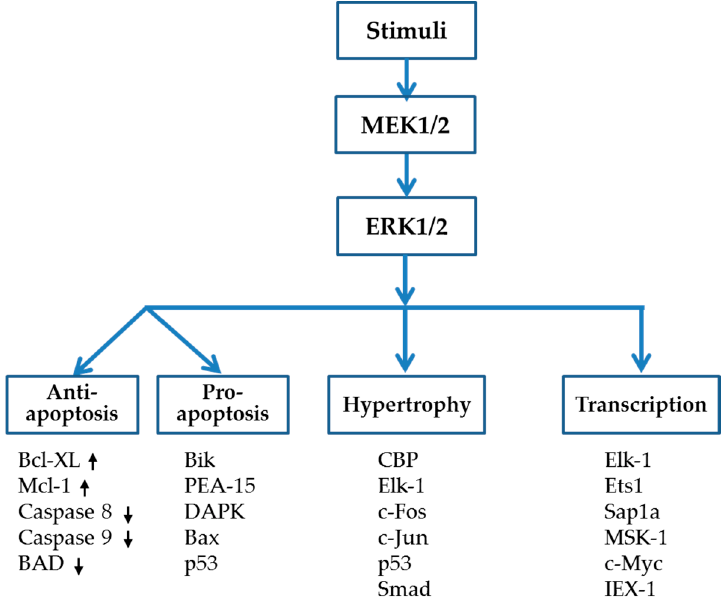
Figure 1. Intracellular targets of ERK1/2.